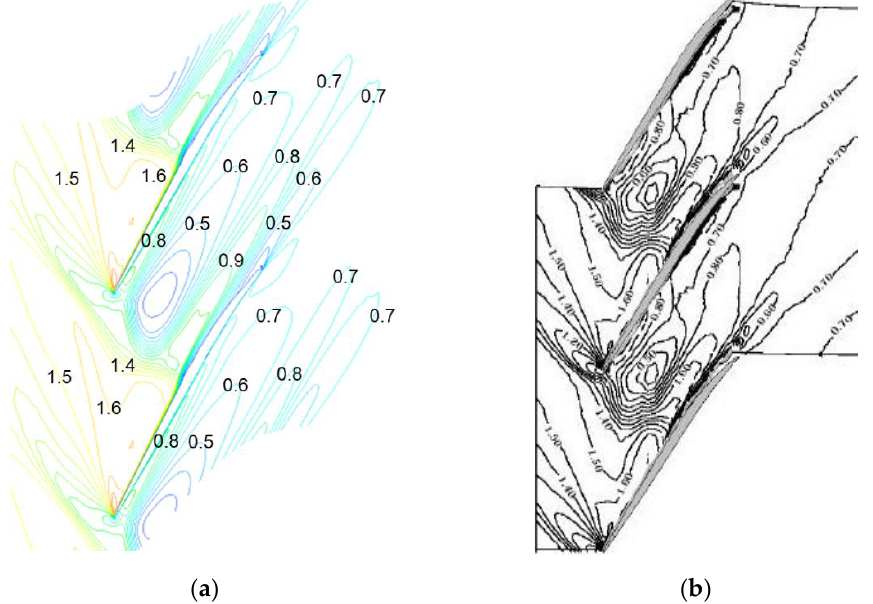
Figure 7. The relative Mach number distribution of the 95% B2B surface at the near stall point ( a ) numerical result; ( b ) experimental result from NASA.